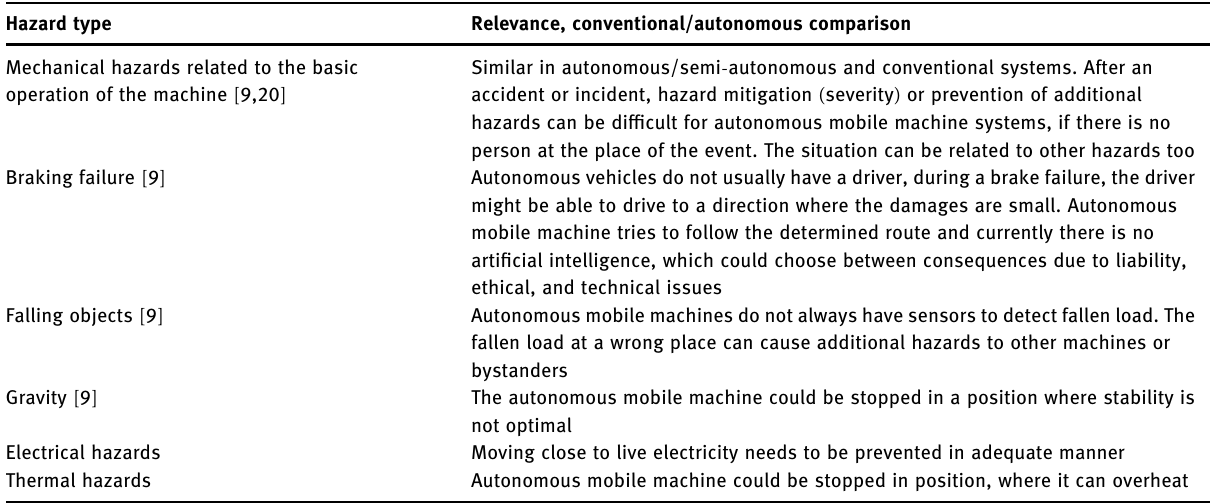
Table 1: Change in hazards, when conventional mobile machine is turned to autonomous Hazard type Relevance, conventional/autonomous comparison Mechanical hazards related to the